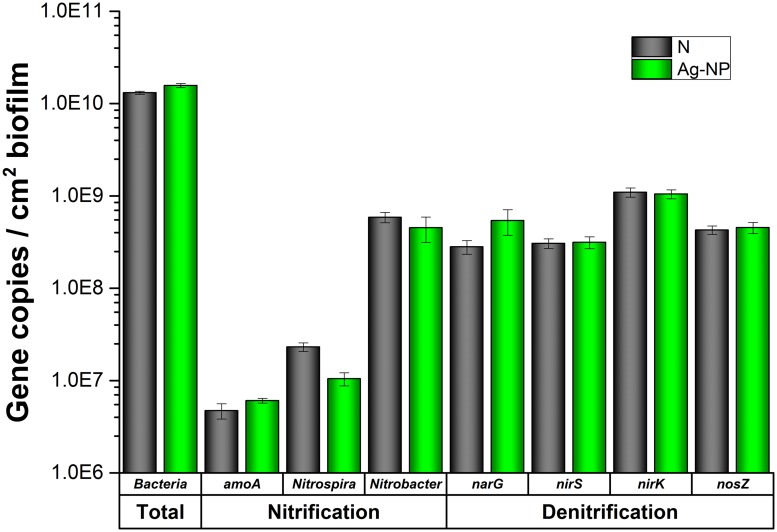
qPCR results. N indicates samples with no treatment and Ag-NP indicates samples with Ag-NP treatment. Error bar indicates SD.